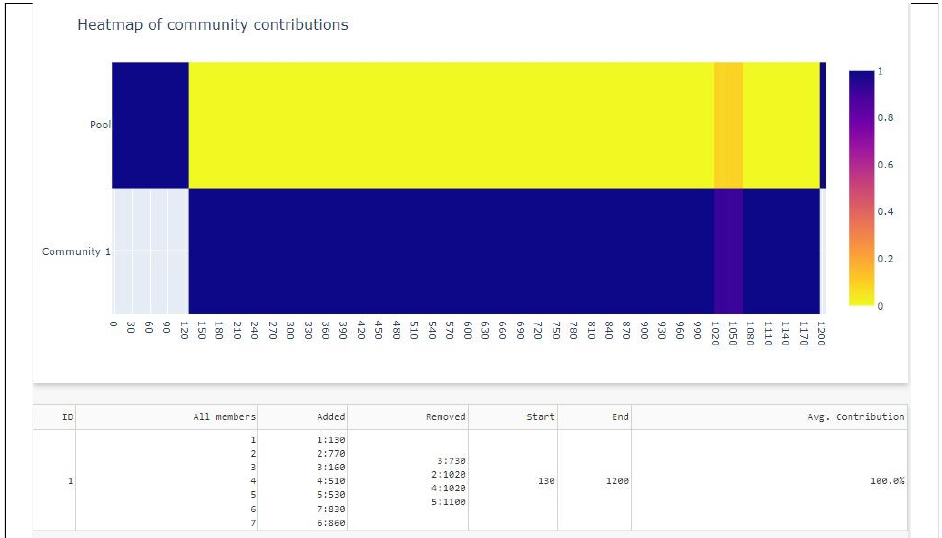
Figure 12. Complexity